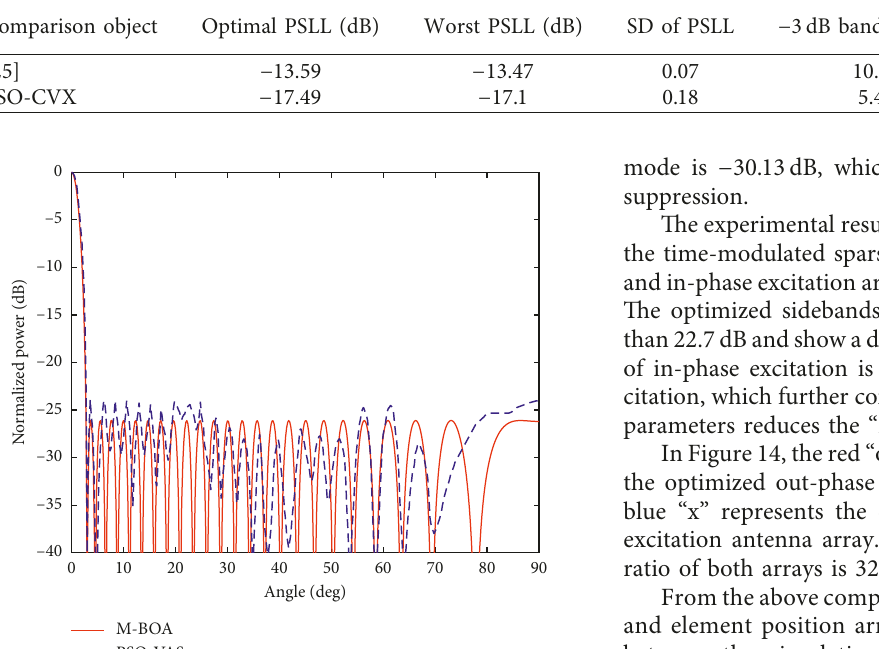
Table 1: PSLL comparison between the array mentioned in [25] and time-modulated sparse array.